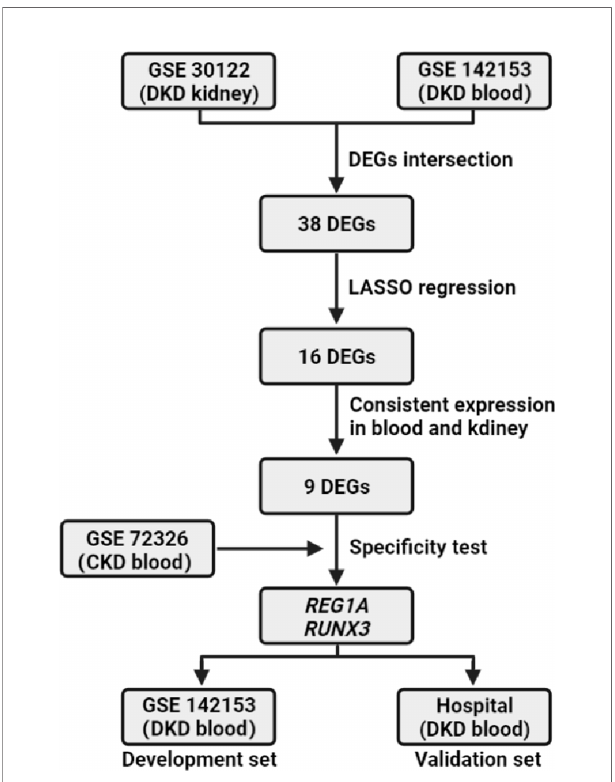
FIGURE 1 | Flowchart. DKD, diabetic kidney disease; CKD, Chronic kidney